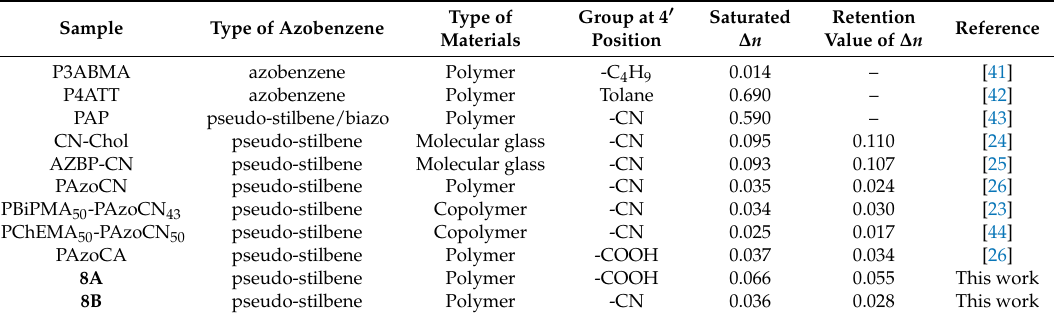
Figure 6. Change of birefringence of 8A , 8B , and 8C at different irradiation time and relaxation time. Table 1. Saturated Δ n and retention value of Δ n of some typical azo materials.